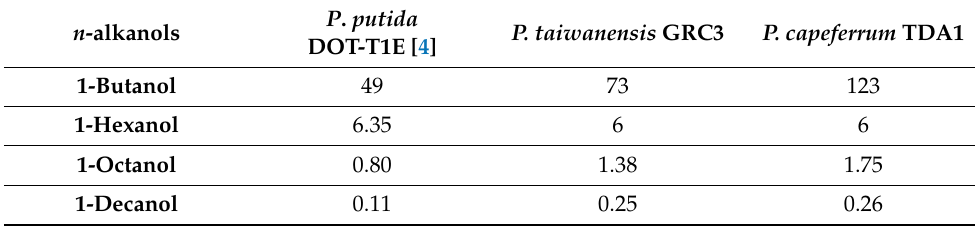
Figure 2. EC50 values for P. taiwanensis VLB120, GRC1, GRC2, GRC3, and P. capeferrum TDA1 grown on ( A ) 1-butanol (dark green squares), ( B ) 1-hexanol (green squares), ( C ) 1-octanol (orange squares), and ( D ) 1-decanol (red squares). Table 2. EC50 values (mM) of the tested n -alkanols in P . putida DOT-T1E (data from [4]), P. taiwanensis GRC3 (see also Figure S1), and P. capeferrum TDA1.